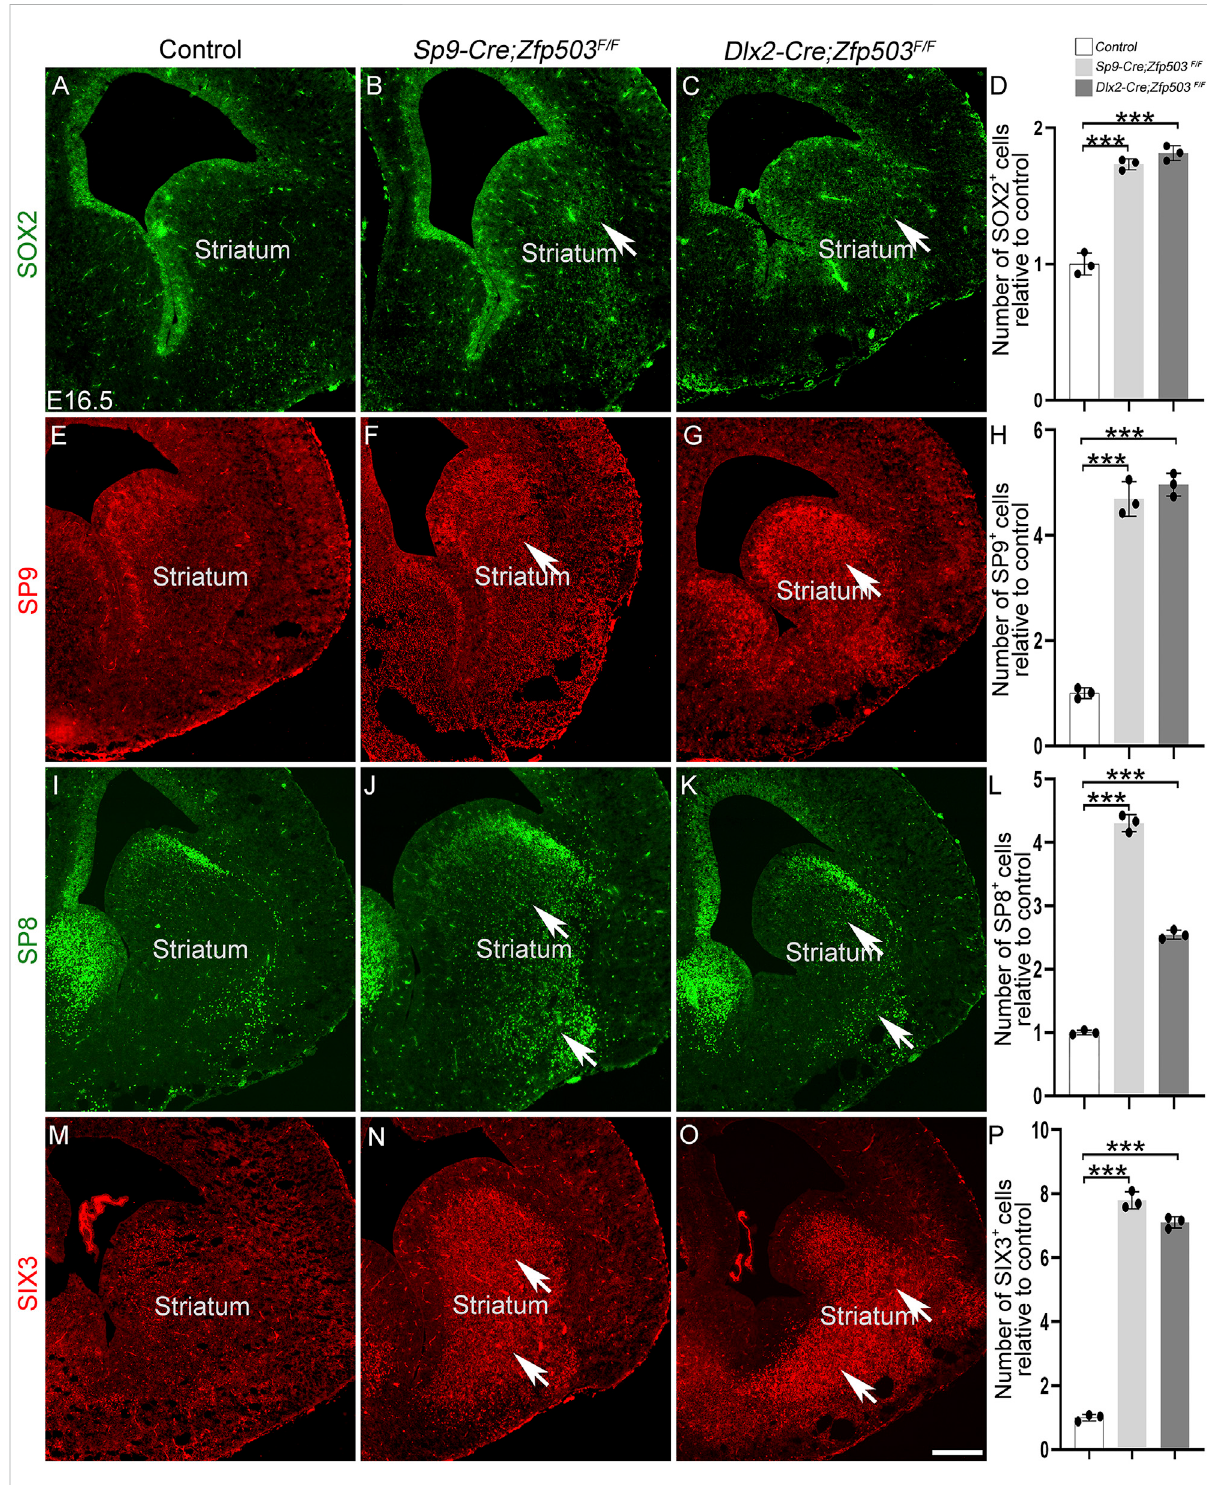
Abnormal expression of precursor marker genes in Zfp503 -CKO mice at E16.5. (A – D) The expression of SOX2 was increased in the entire striatum of Zfp503 -CKO mice at E16.5. (E – L) The transcription factors Sp8 and Sp9 were increased in the striatum of Zfp503 -CKO mice at E16.5. (M – P) Six3 expression was present in the whole striatum in Zfp503 -CKO mice, but not in control mice. One-way ANOVA followed by the Tukey – Kramer post hoc test, ***P < 0.001, n = 3, mean ± SEM. Scale bar: 200 µm in O for (A – O)